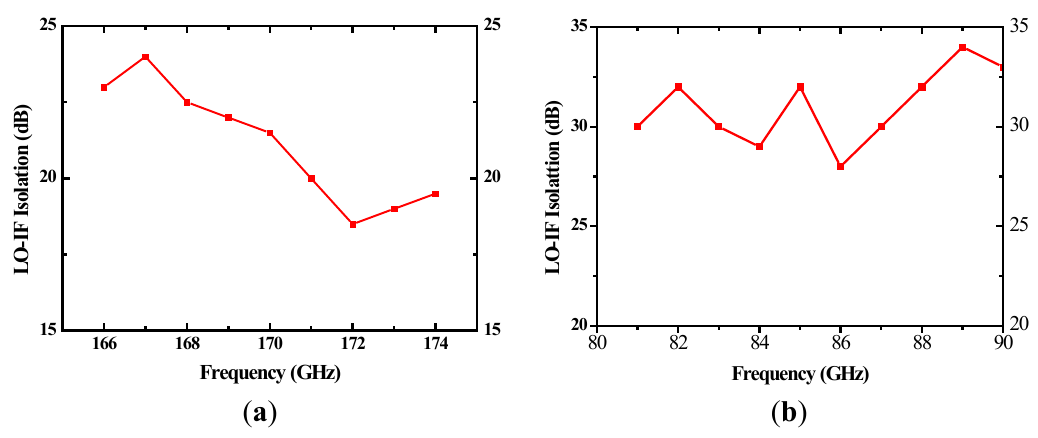
Figure 9. LO-IF port isolation: ( a ) simulated isolation of 2× SHM and ( b ) measured isolation of 4× SHM.